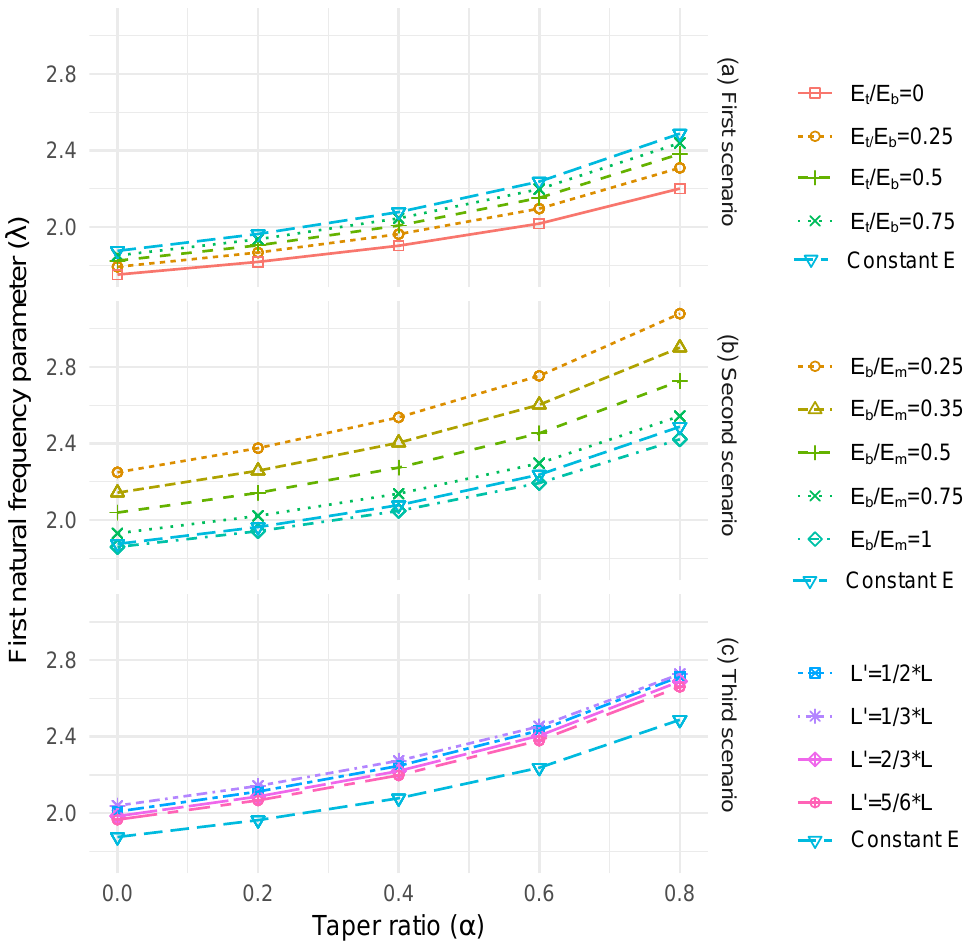
Figure 5. ( a ) Taper ratio versus first natural frequency parameter ratio with longitudinal sti ff ness variation linearly from the bottom to the top end of the tree (first scenario), ( b ) taper ratio versus first natural frequency parameter ratio with longitudinal sti ff ness variation linearly from the bottom to one-third of the tree height, followed by a linear variation till the top end of the tree (second scenario) and ( c ) taper ratio versus first natural frequency parameter ratio with longitudinal sti ff ness variation linearly from the bottom to L’, followed by a linear variation till the top end of the tree (third